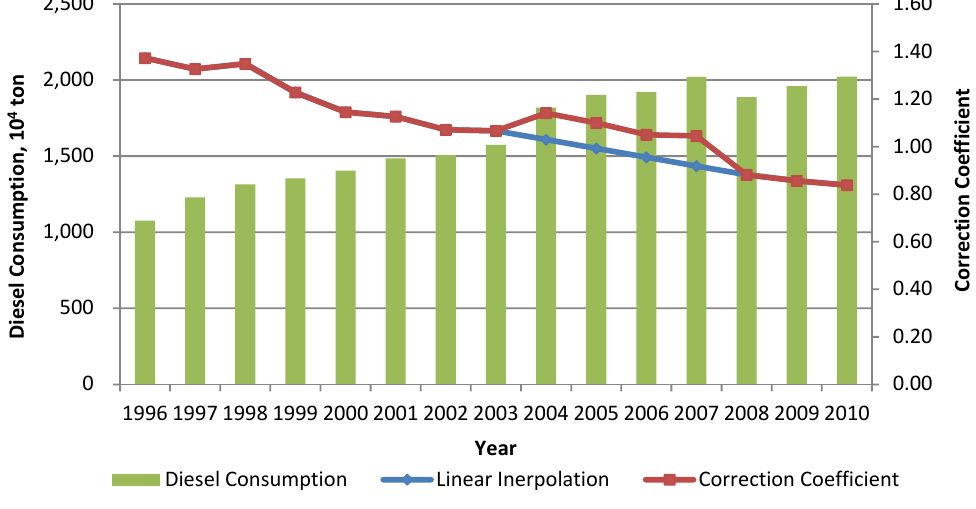
Figure 5. Correction coefficient and diesel consumption